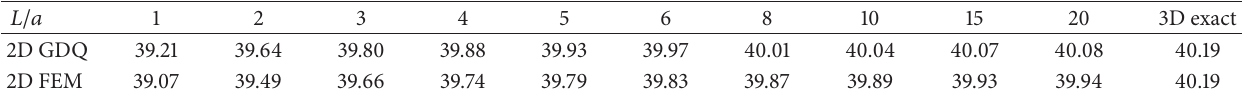
Table 2: First frequency 𝑓 in Hz for the 𝑎/ℎ = 100 one-layered FGM plate with 𝑝 = 0.5 : convergence of 2D GDQ and 2D FE solutions increasing the length of the simply supported sides.